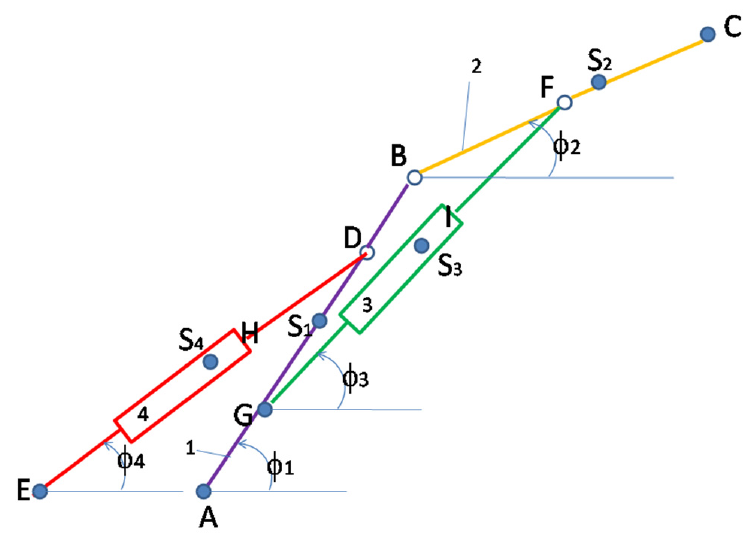
Figure 15. A simple articulated robot, operated with two linear actuators (a 6R2T robot). The kinetic energy of the whole mechanism is conserved (Equation(6)) [38,39]: